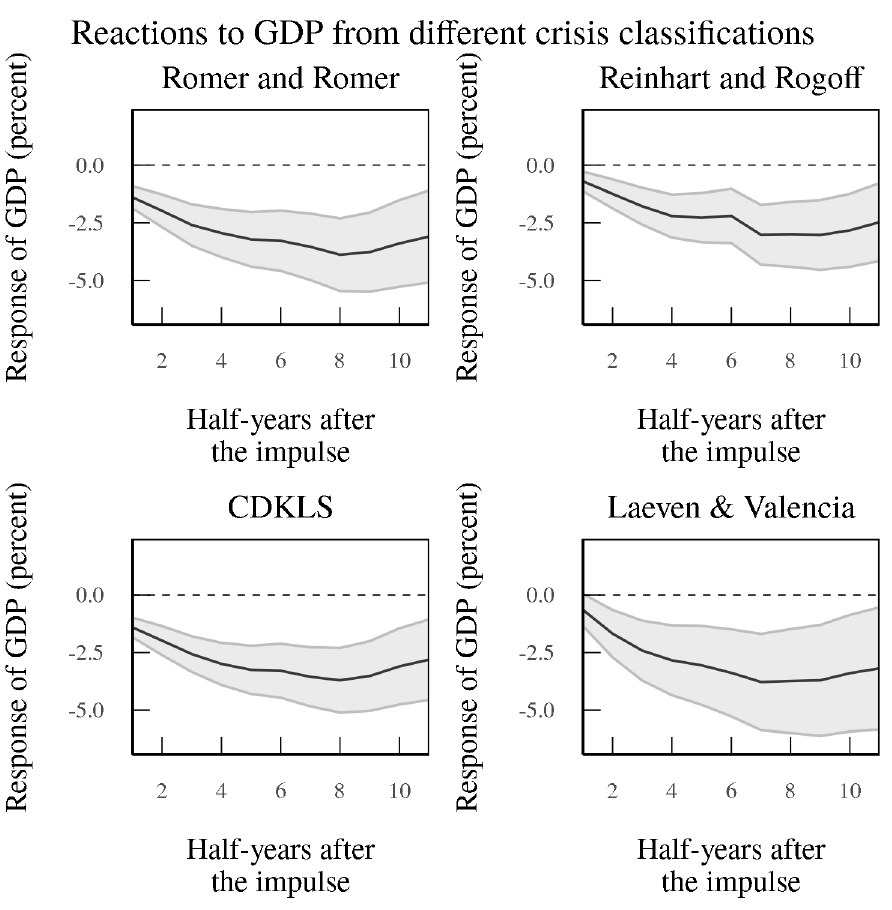
Figure 18. Local Projection Results . Note: This figure shows the predictions of Romer 5+ crises on 2005–2012 OECD text at the 0.55 true positive rate for the Chen–DeHaven–Kitschelt–Lee–Sicilian (CDKLS) model ( bottom left ) and the Average Model trained on the period 1981–2004 using OECD text. It can be seen that both models have similar magnitudes in terms of the impulse response of GDP compared to expert-identified crises: Romer and Romer (2017) ( top left ), Reinhart and Rogoff (2009) ( top right ), and Laeven and Valencia (2013) ( bottom right